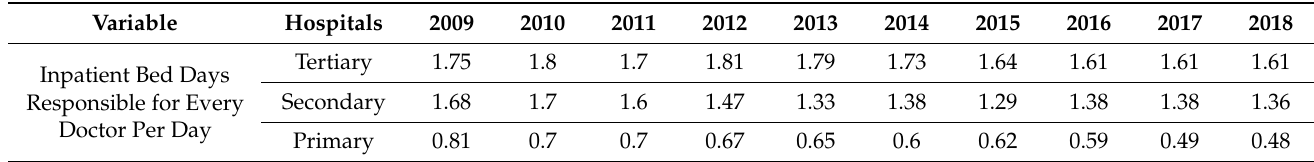
Table 3. Inpatient bed days responsible for every doctor per day of different level public hospitals in Beijing from 2009 to 2018